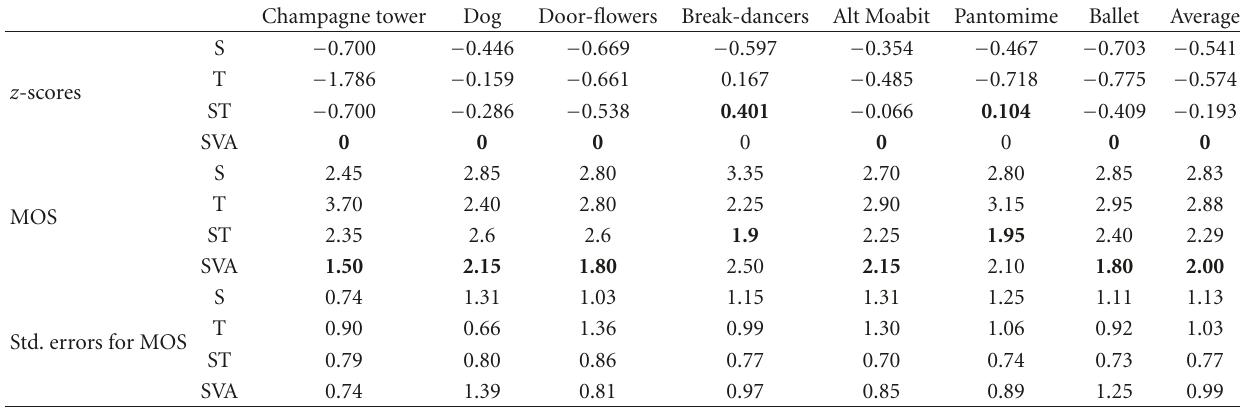
Table 2: z -scores, mean opinion score and standard errors for ROI extraction schemes. Champagne tower